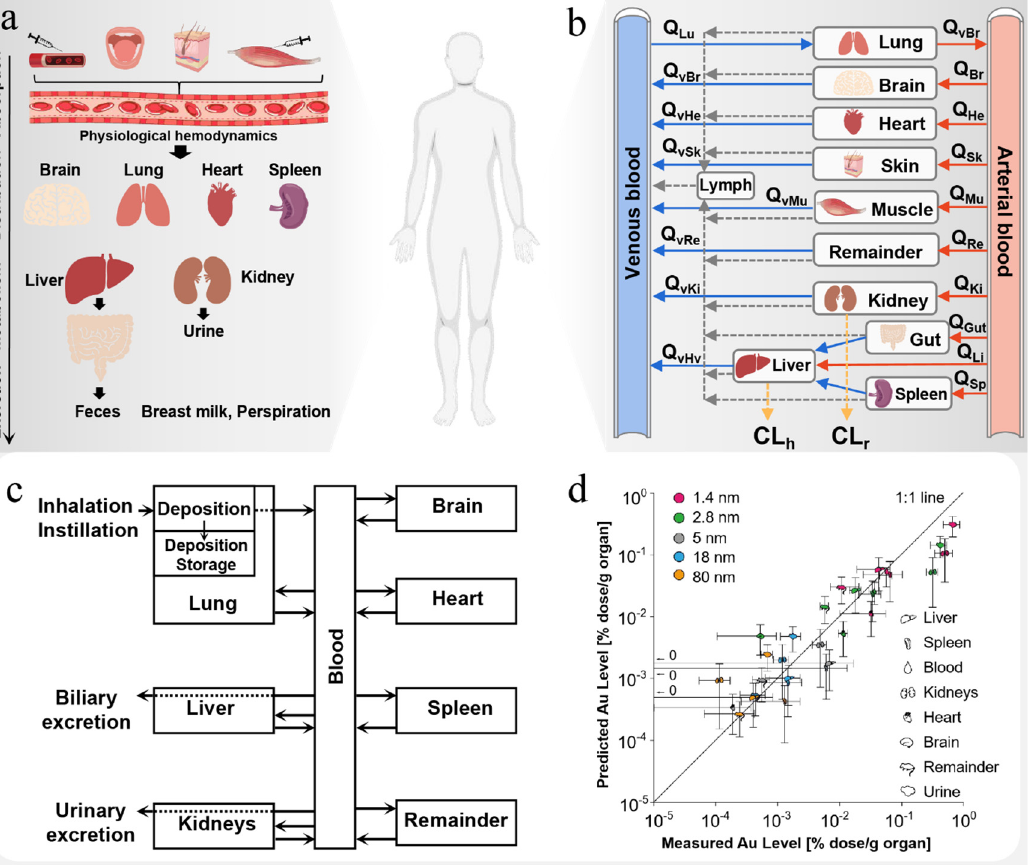
Figure 5. ADME process in vivo and PBPK model of nanodrugs. ( a ) ADME of nanoparticles in vivo. Adapted with permission from [53], Elsevier, 2020. ( b ) Schematic diagram of PBPK model structures for nanoparticles. ( c ) Schematic diagram of the AuNP PBPK model. ( d ) Comparison between simulation results and experimental results of the AuNP biodistribution. Adapted with permission from [54], Springer,